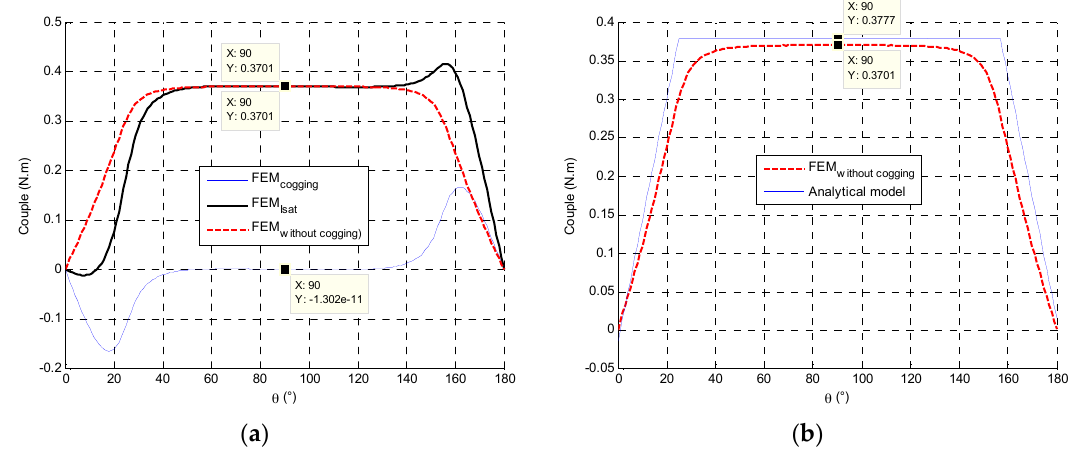
Figure 8. ( a ) The FEM torque evolution between cogging torque and torque at fixed current; ( b ) The torque comparison in a linear behavior between the analytical model and FEM model.